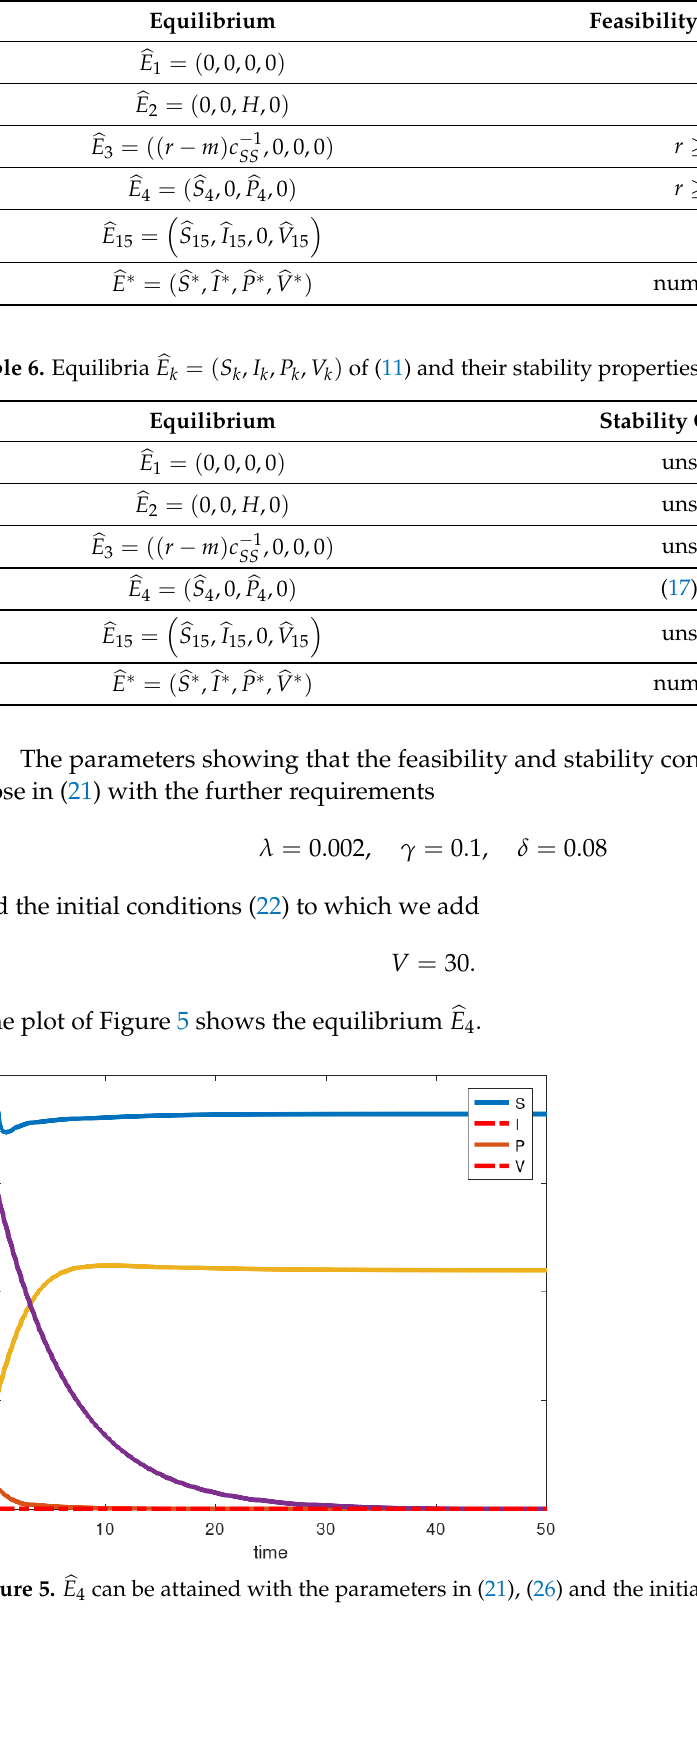
Table 5. Equilibria (cid:98) E k = ( (cid:98) S k , (cid:98) I k , (cid:98) P k , (cid:98) V k ) of (11) and their feasibility.